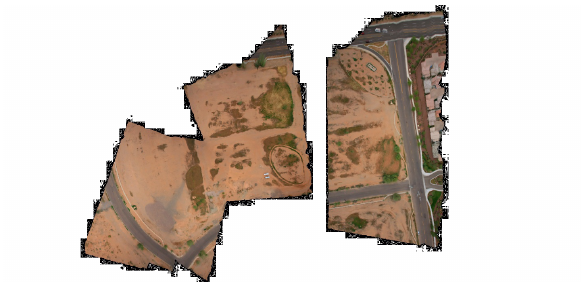
Figure 13: Model generated at local Northgate flight field (350 x 200